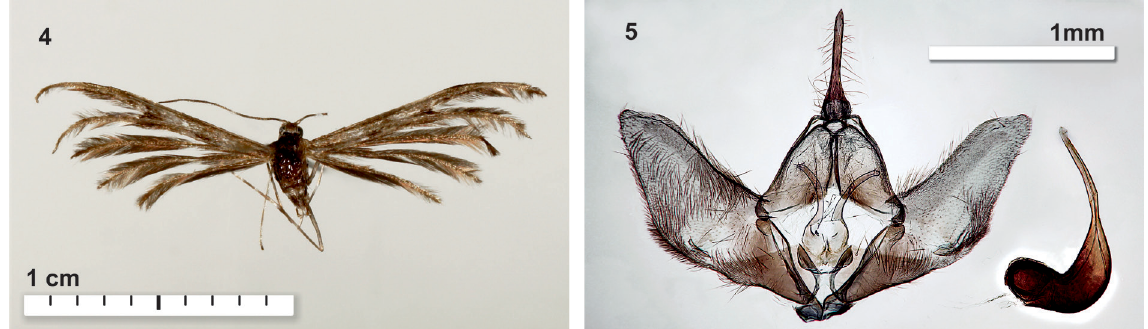
Figs 4–5. Singularia sinjaevi Kovtunovich & Ustjuzhanin sp. nov. 4 . Holotype (ZISP 1838). 5 . Holotype, genitalia (ZISP